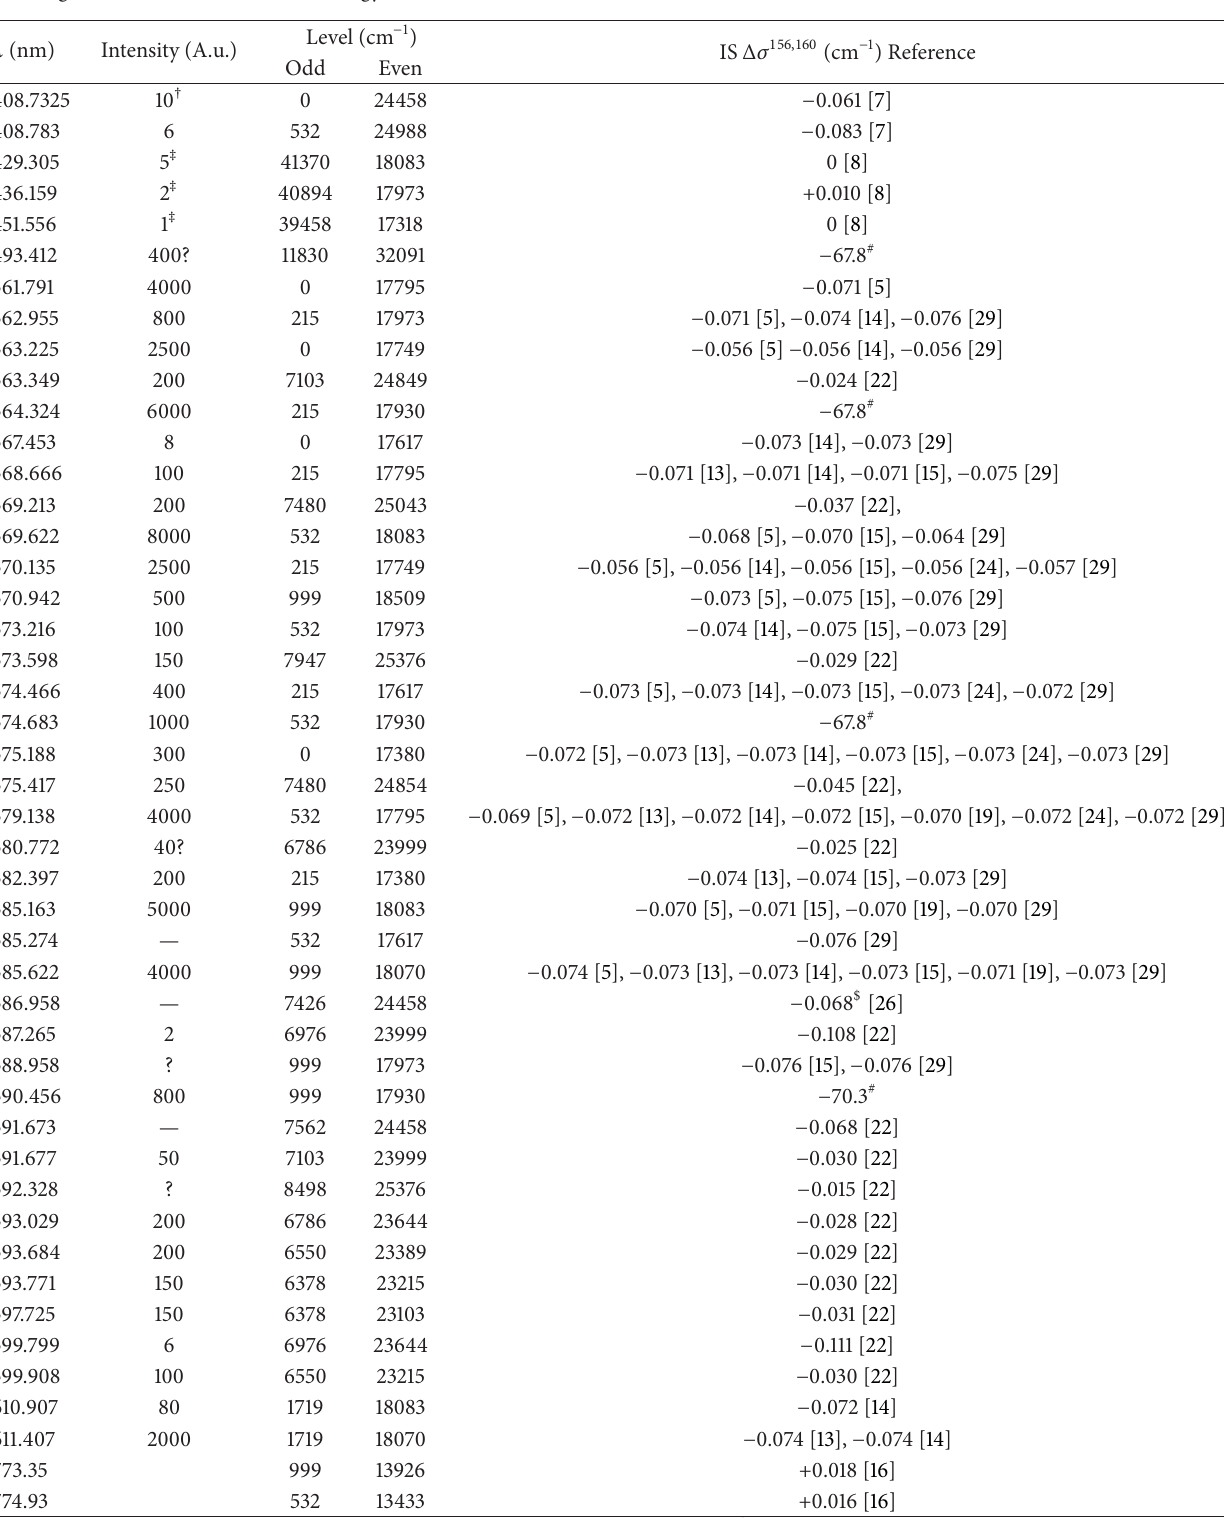
Table 2: IS Δ𝜎 156,160 data in the 42 spectral lines of Gd I covering the region of 4087–7749 ˚A; the listed literature data mostly studied by means of laser spectroscopy have been employed to evaluate the LIS, Δ𝑇 156,160 of the presently involved levels. Units of measurements were wavelengths (nm), intensities (A. u.), energy levels (cm − 1 ), and IS (cm − 1